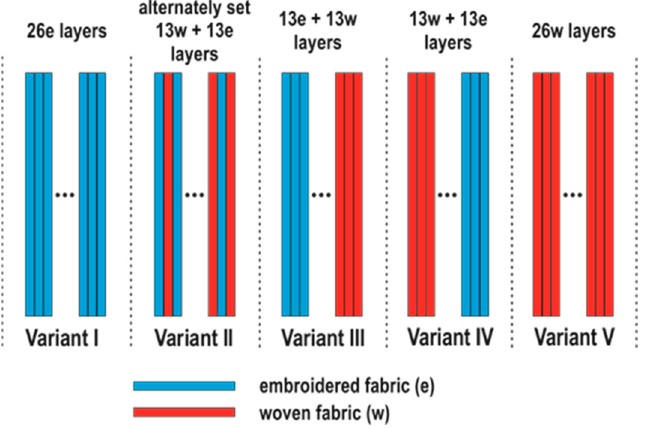
Figure 2. Variants of execution of ballistic packages .